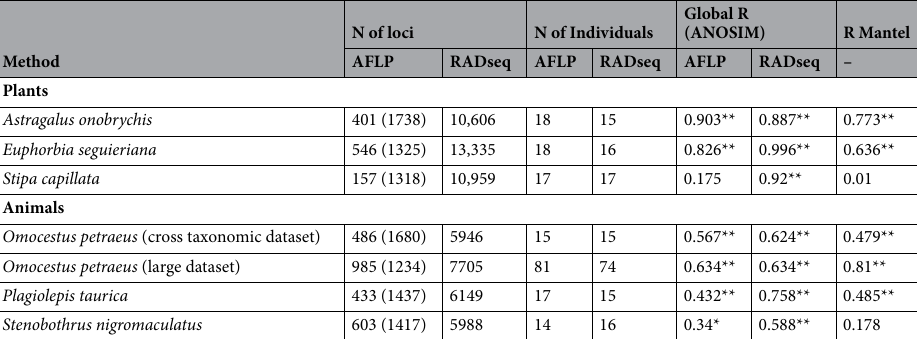
Table 1. Locus yield before (in parentheses) and after quality control from amplified fragment length polymorphism (AFLP) for the six studied taxa and locus yield for restriction site associated DNA sequencing (RADseq) for the six studied taxa. Global R values derived from Analysis of Similarity (ANOSIM)- and Mantel correlation coefficients calculated from the respective datasets and taxa; asterisks depict significance level (** = p > 0.01, * = p >